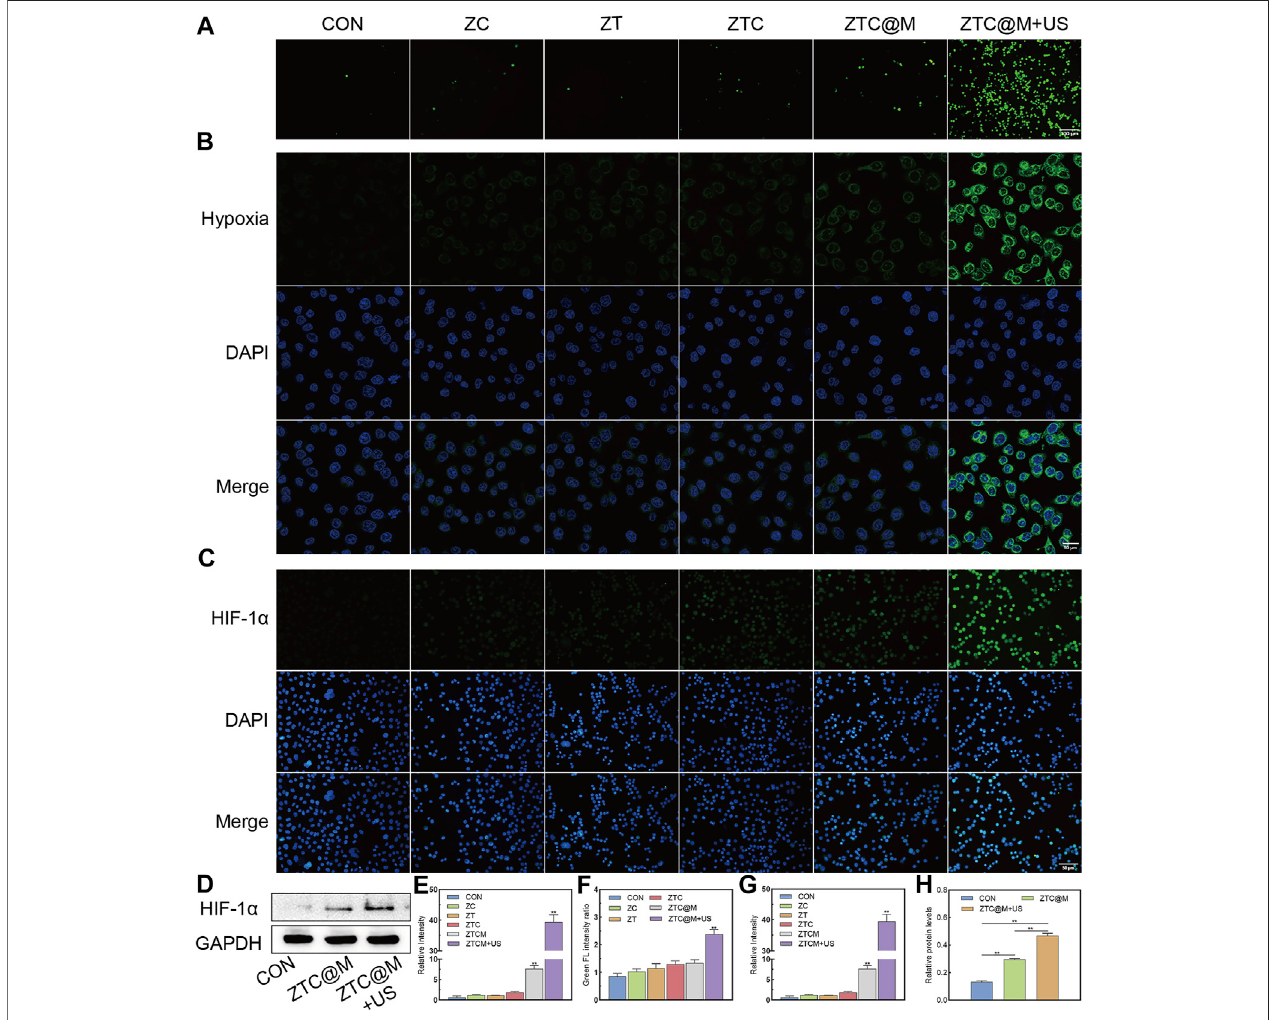
FIGURE 5 | In vitro ROS/hypoxia assay and IF. ROS production was detected by fl uorescence of DCFH-DA in AGS cells (A) (100×). Intracellular hypoxia imaging using Image-iT ™ Green Hypoxia Reagent asthe syndicator (B) (200×). Immuno fl uorescence images ofAGS stained by HIF-1 α (C) (200×). Gel images ofHIF-1 α in AGS cells treated with ZTC@M + US (D) . Quanti fi cation ofintracellular fl uorescence intensity in A (E) , B(F) , and C(G) . Thebar chart indicates the relative density ofHIF-1 α to GAPDH in D (H) . * p < 0.05, ** p <